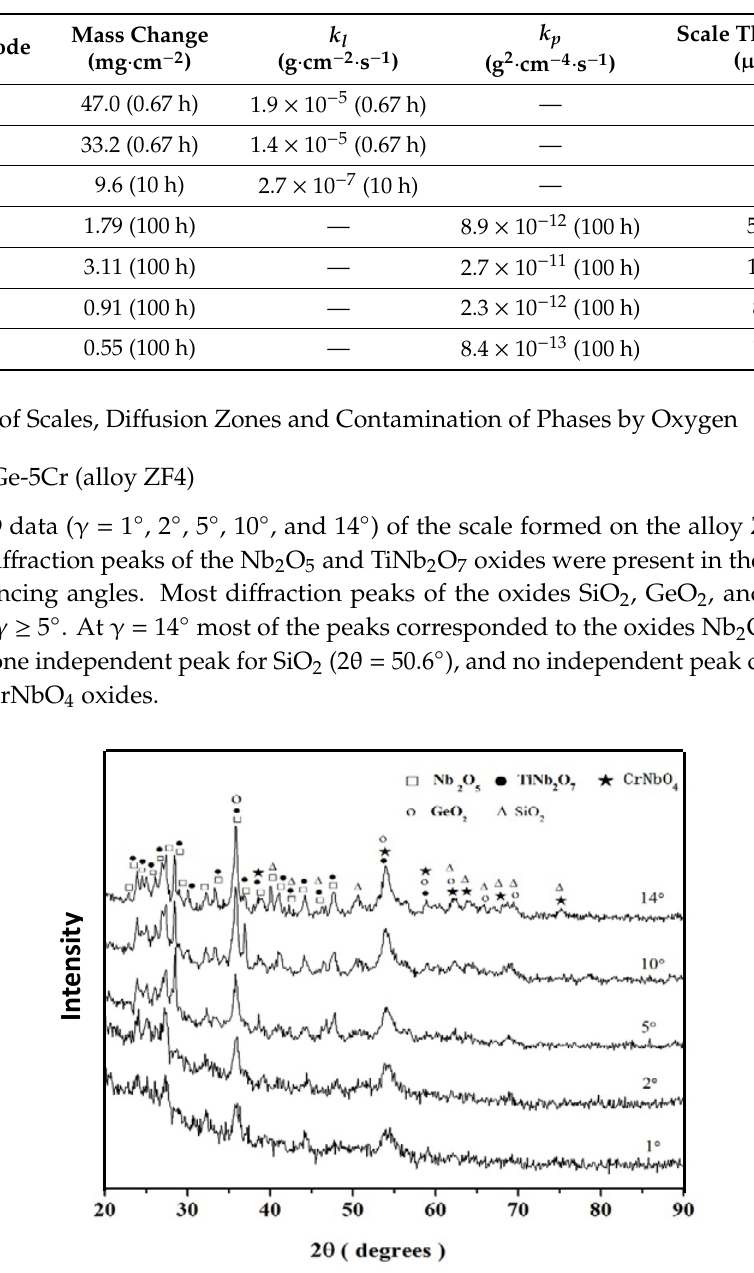
Figure 3. GXRD data (γ = 1 °, 2°, 5°, 10°, and 14°) for the scale formed on the alloy ZF4 at 800 °C in air.